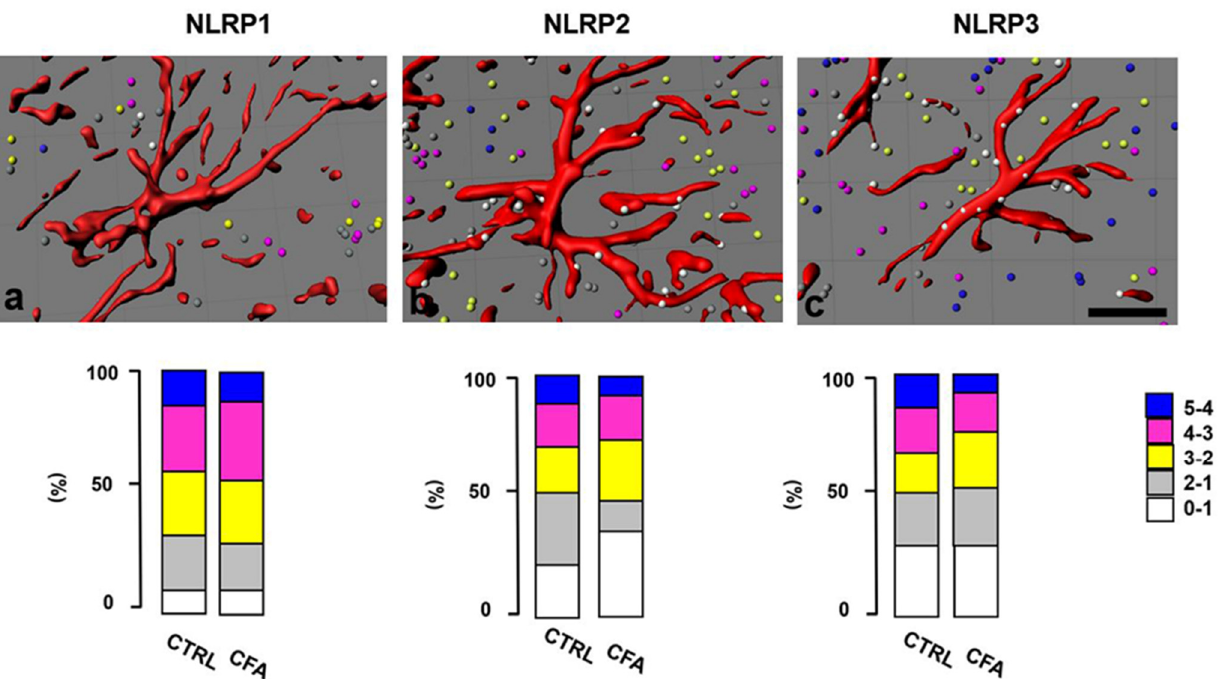
Figure 7. Distance measurement of NLRP markers from astrocyte profiles. Illustrations showing IMARIS rendered confocal double-stained z-stack images with putative distance (0–5 μ m) of NLRP1 ( a ), NLRP2 ( b ) and NLRP3 ( c ) inflammasomal proteins (colorful spots, indicated by a color scale) from GFAP-positive astrocyte profiles (red). In the case of NLRP1 and NLRP3, no significant changes were detected in distance distribution between control (CTRL) and chronic inflammatory pain (CFA); however, for the NLRP2 marker, a significant increase ( p = 0.0004) in spot number was calculated in the range of 0–1 μ m in chronic pain in comparison with control. Scale bars: 10 μ m